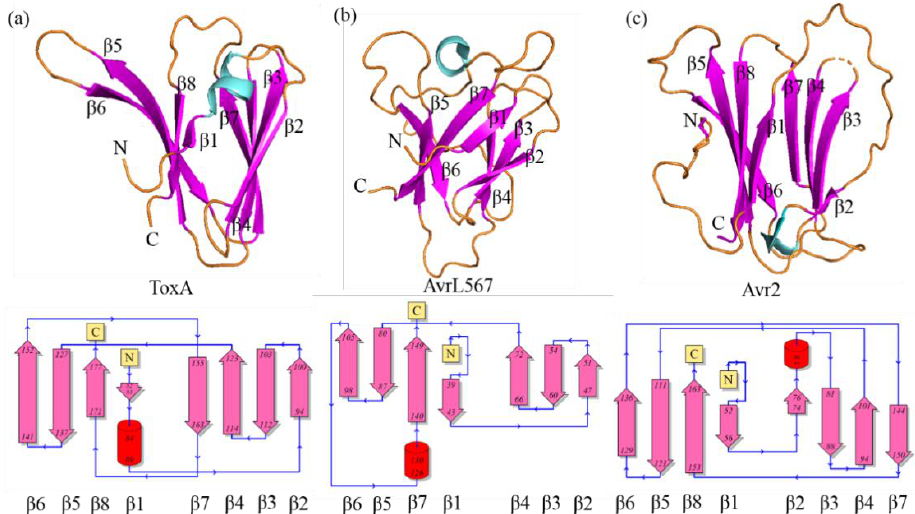
Figure 1. Structures of effector proteins from the ToxA-like family: ( a ) ToxA (PDB ID: 1ZLD), ( b ) AvrL567 (PDB ID: 2QVT) and ( c ) Avr2 ( Fol ) (PDB ID: 5OD4). The β -strands are shown in purple and the α -helix is shown in cyan. The structural topology of the secondary structures is shown below each corresponding structure. Figure was used under the terms of the Creative Commons Attribution License (CC-BY 4.0) [24].